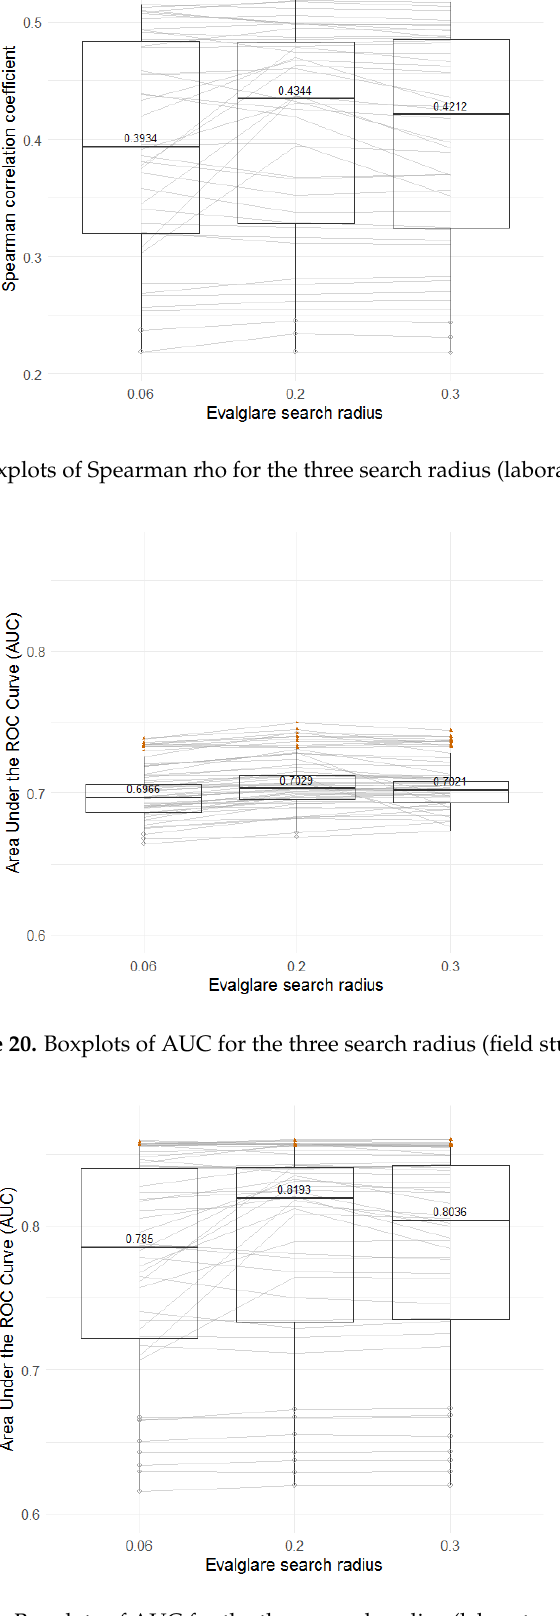
Figure 18. Boxplots of Spearman rho for the three search radius (field study).